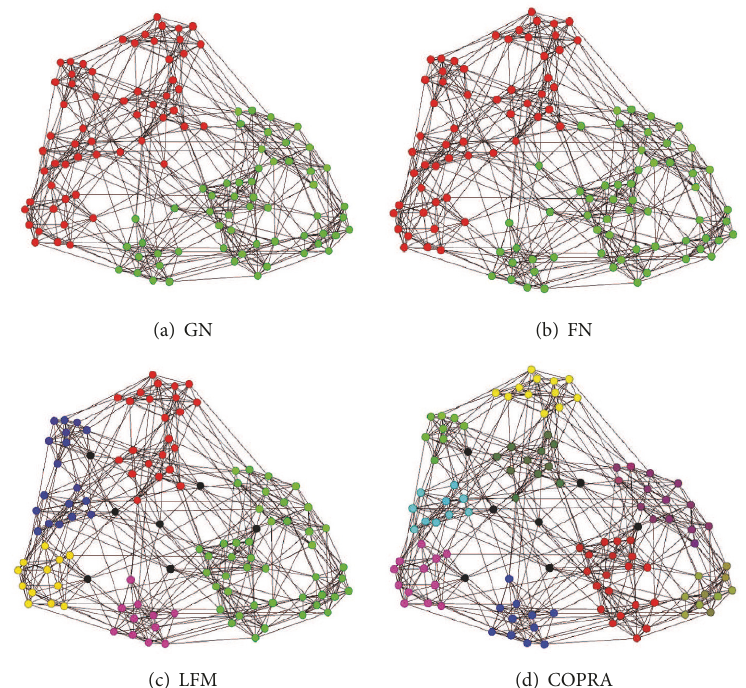
Figure 10: The detected communities with nonclassical algorithms on football.